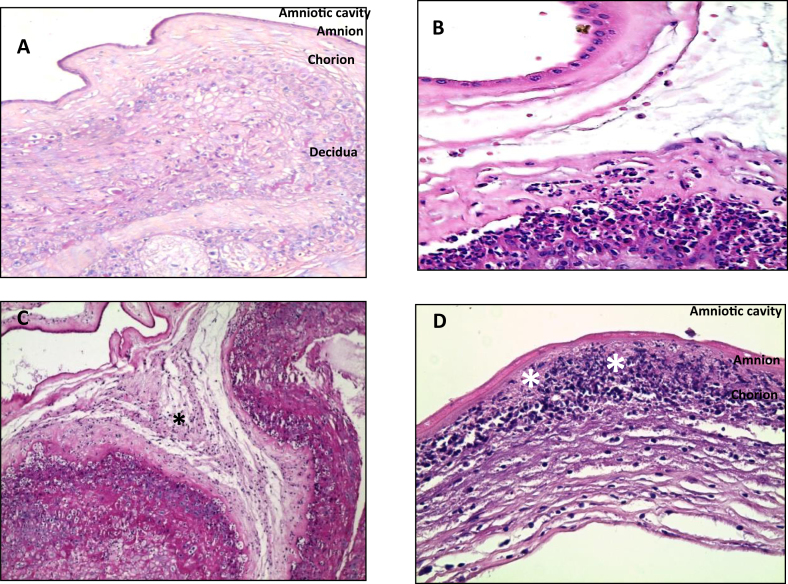
Staging of acute chorioamnionitis: Maternal inflammatory response (HE) A. Normal chorioamniotic membranes shows the absence of neutrophils; B. Acute chorionitis is stage 1 acute inflammation of the chorioamniotic membranes, in which neutrophilic infiltration is limited in the chorionic and sub-chorionic space (S1G1); C, Acute chorioamnionitis is stage 2 acute inflammation of the chorioamniotic membranes; neutrophilic migration into the amniotic connective tissue is shown (asterisk) (S2G2); D. Necrotizing chorioamnionitis is stage 3 acute inflammation of the chorioamniotic membranes, whose characteristic is the amnion epithelial necrosis (asterisk) (S3G3). ∗ Redline RW and col classification.